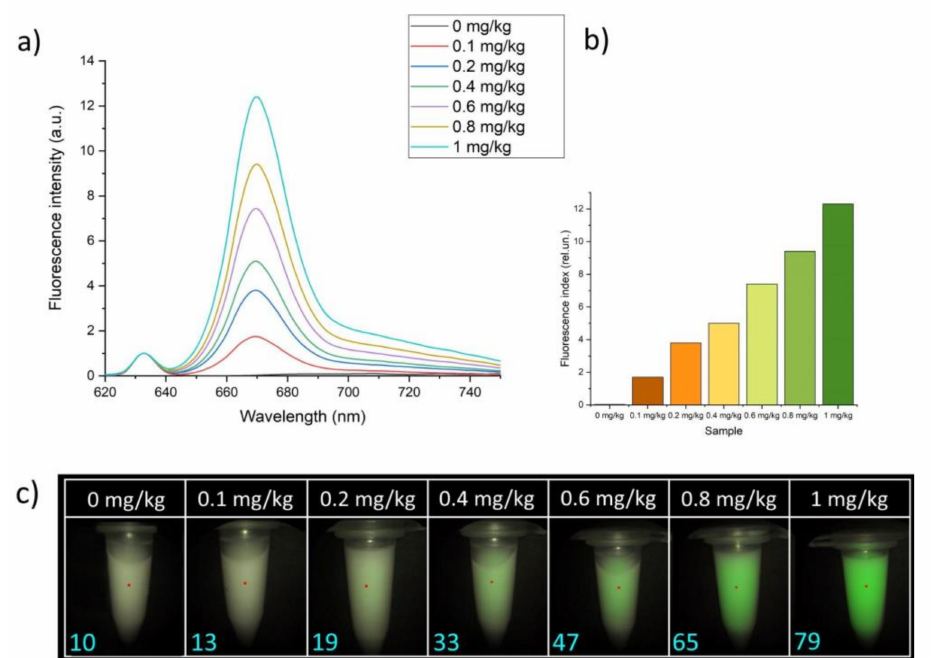
Figure 2. ( a ) Fluorescence PS spectra of the phantom samples normalized to the laser line ( λ ex = 632.8 nm), ( b ) the histogram of the fluorescence index of the phantom samples, and ( c ) images of the phantom samples with different concentrations of the PS. The fluorescence index is displayed in the lower left corner of the image. A fluorescence index ≤ 10 shows the accumulation of PS in normal tissue after intravenous